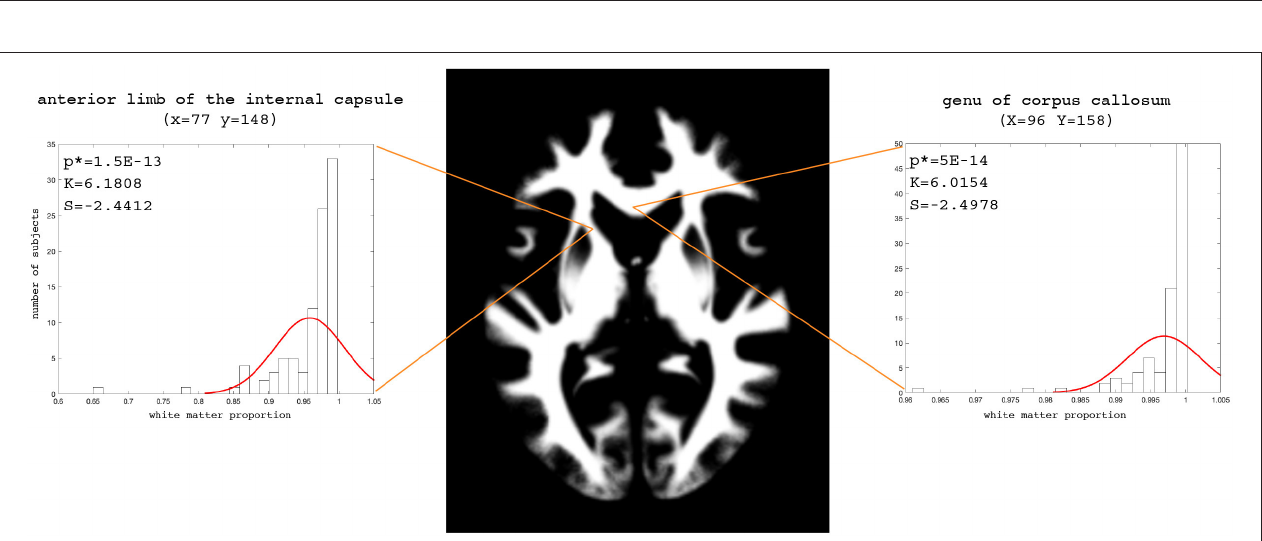
FIGURE 4 | Axial slice (z = 83) for the median white matter map. The histograms with the skewness (S), kurtosis (K), and Shapiro-Wilk test p -values (p*) for the anterior limb of the internal capsule and genu of the corpus callosum.